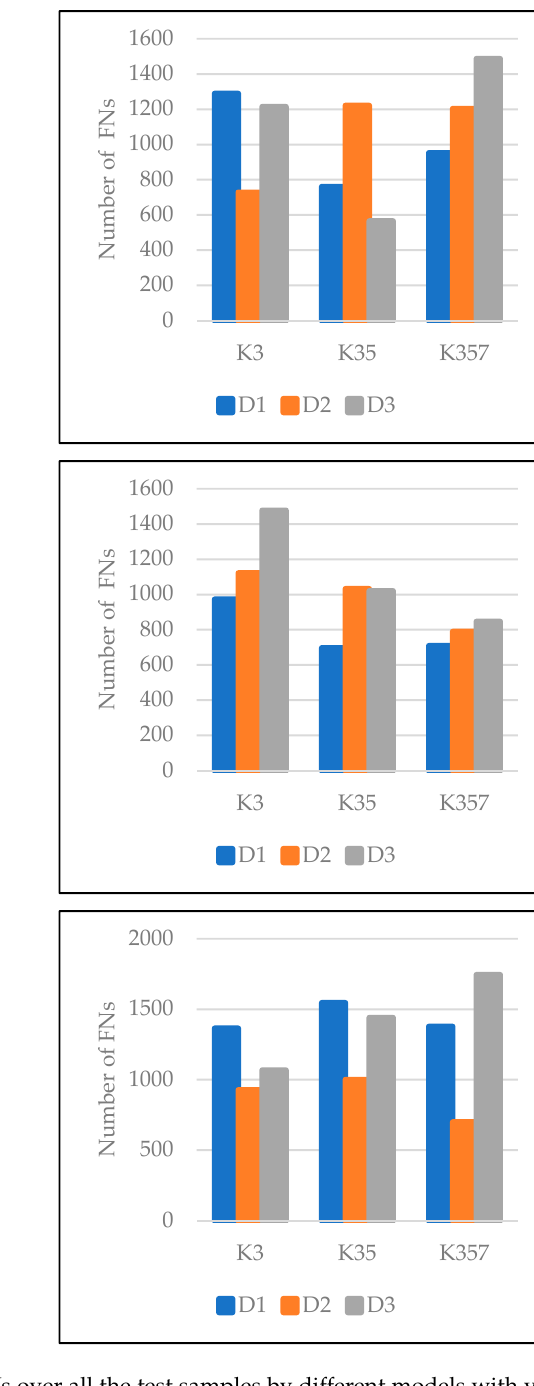
Figure 13. The number of FPs and FNs over all the test samples by different models with various kernel sizes and dilation rates in MultiScale-Net.